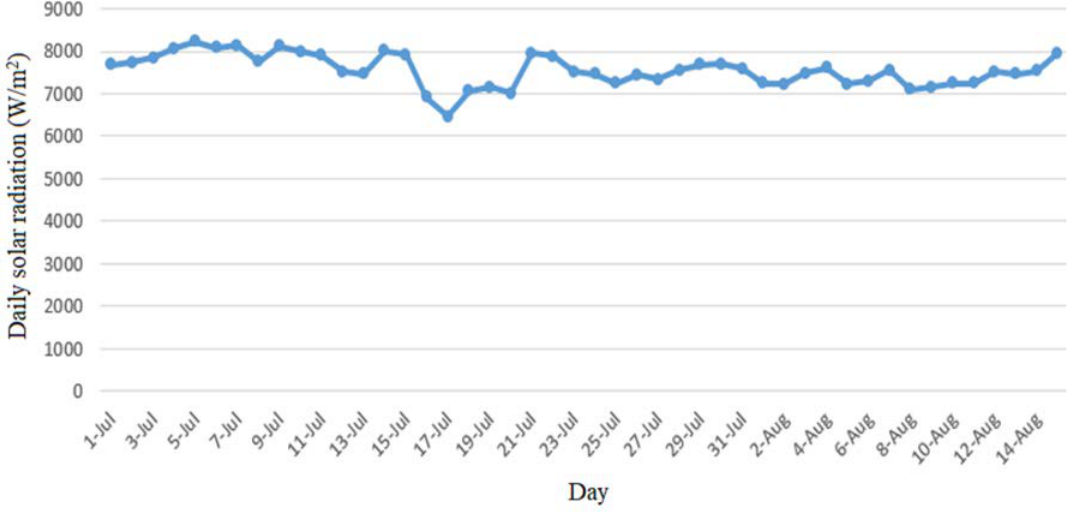
Figure 10. Daily solar radiation in W/m 2 of the site under study (during 2019).